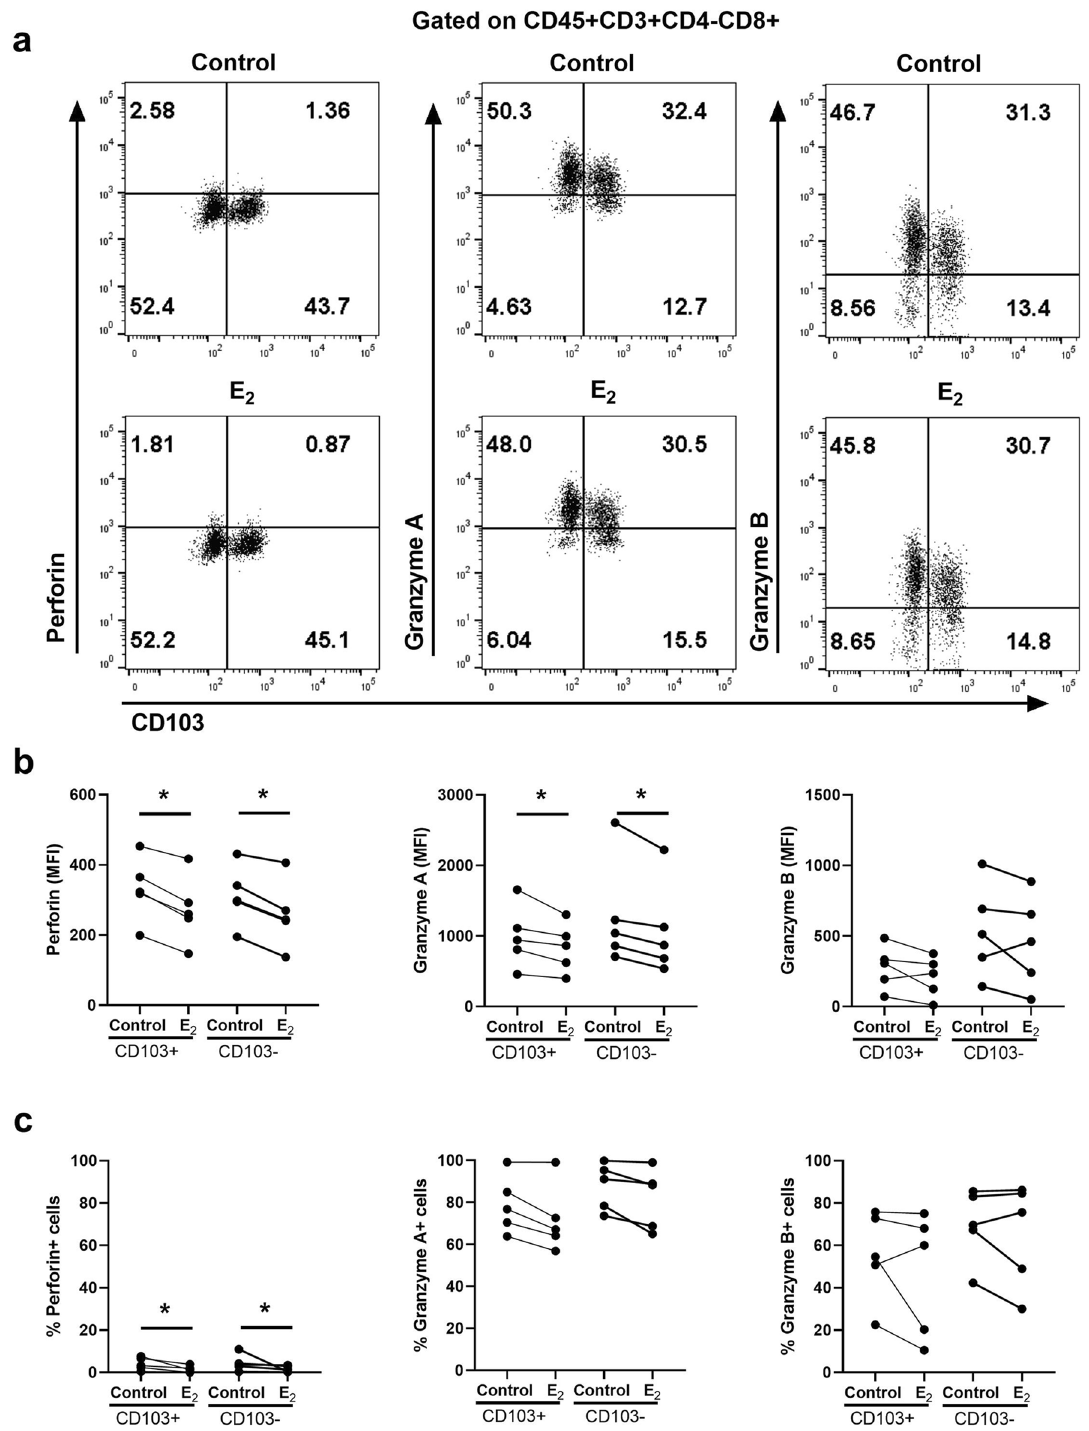
Figure 3. Effect of E 2 on intracellular cytotoxic molecules in endometrial CD103+ and CD103−CD8+T cells. Mixed cell suspensions from endometrium were pre-treated with E 2 (5 × 10 –8 M) for 48 h and stained for the intracellular cytotoxic molecules perforin, granzyme A and granzyme B for analysis by flow cytometry. ( a ) Representative dot plots of intracellular perforin (left), granzyme A (middle) and granzyme B (right) expression in endometrial CD103+and CD103−CD8+T cells treated with E 2 . Top row shows control group (without E 2 ) and bottom row shows E 2 treated group. ( b ) Median fluorescence intensity (MFI) of perforin (left), granzyme A (middle), granzyme B (right) and ( c ) percentage of perforin+ (left), granzyme A+ (middle), granzyme B+ (right) in endometrial CD103+and CD103−CD8+T cells following incubation with E 2 . Each dot represents a different patient (n = 5). * P < 0.05; Friedman test with Dunn’s multiple comparisons